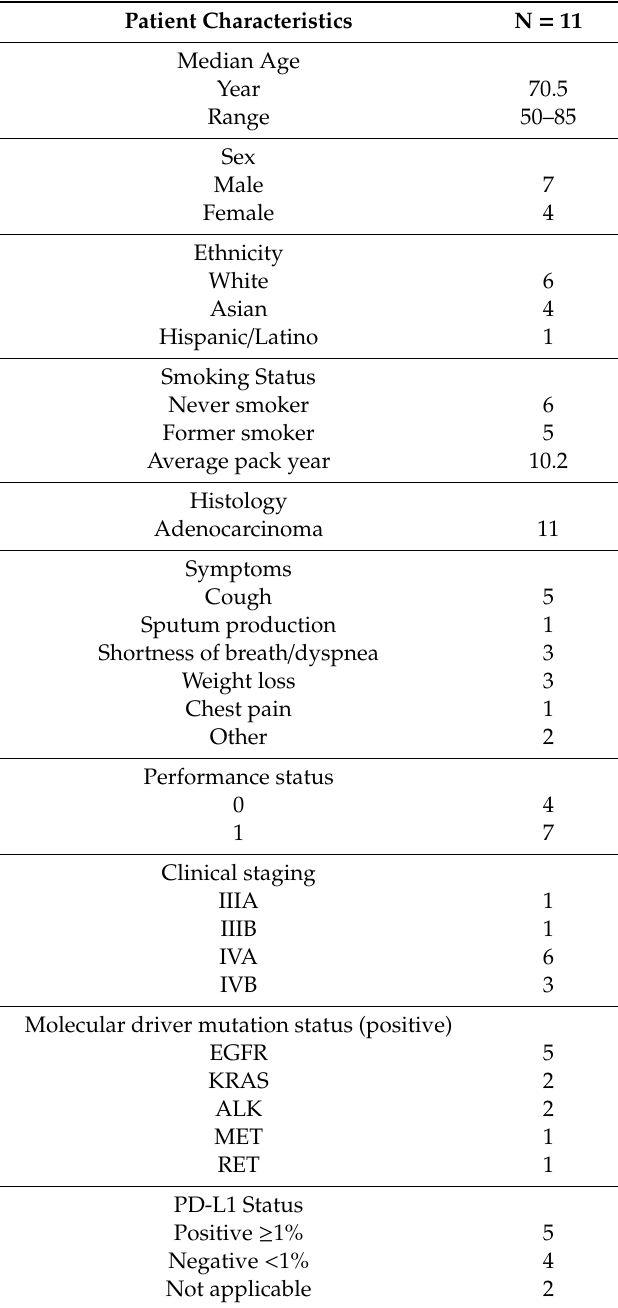
Table 1. Patient